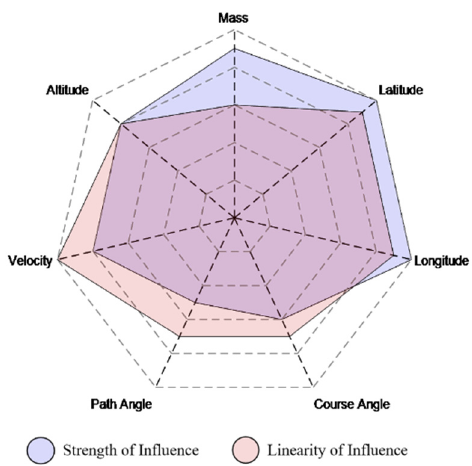
Figure 3. Influence strength and linearity of state variates on the reachable domain.